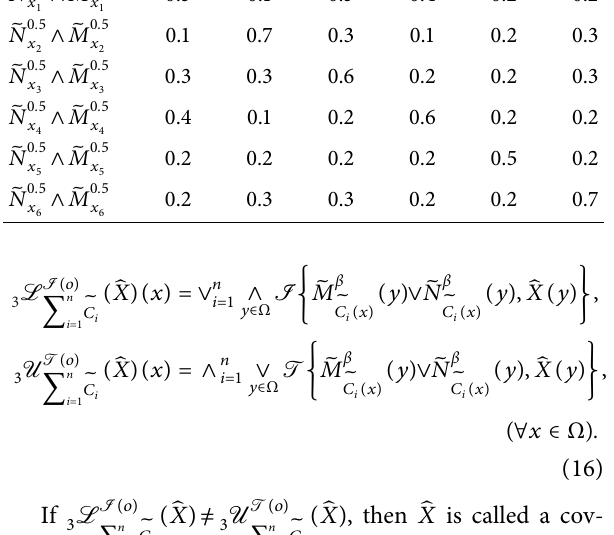
Table 8: Table for 􏽥 N 0 . 5 x 1